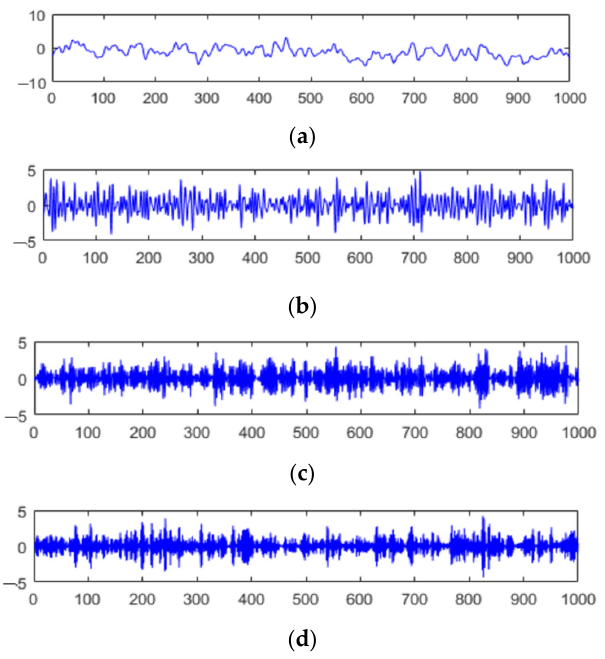
Figure 9. The modal component obtained by decomposing the detected signal. ( a ) Modal 1; ( b ) Modal 2; ( c ) Modal 3; ( d ) Modal 4.